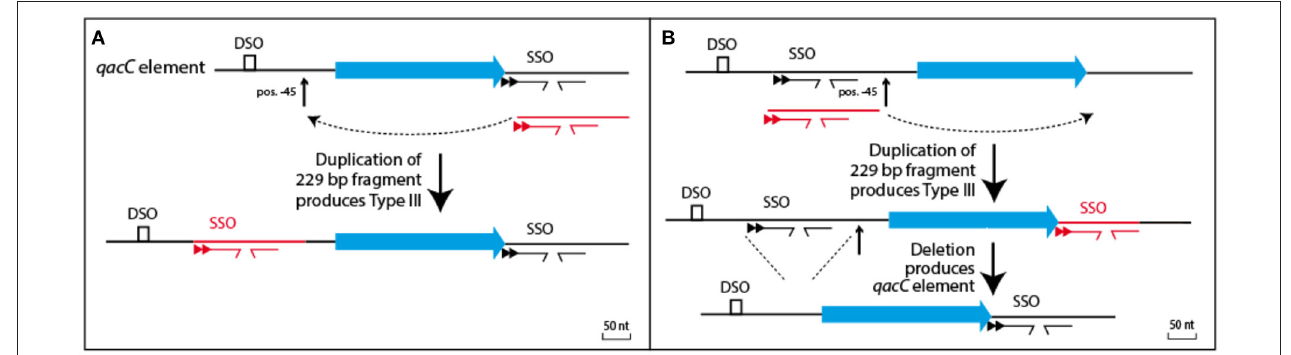
FIGURE 4 | Relationship between Types I/II and Type III plasmids. (A) Type III could be formed from the qacC element by a single duplication event whereby the downstream flank is inserted into a hotspot for recombination, positioned 45 nt upstream of qacC . (B) Alternatively, a precursor can be hypothesized with qacC next to DSO and SSO. A duplication of the SSO-bearing segment would result in Type III, after which a deletion would produce the qacC element.